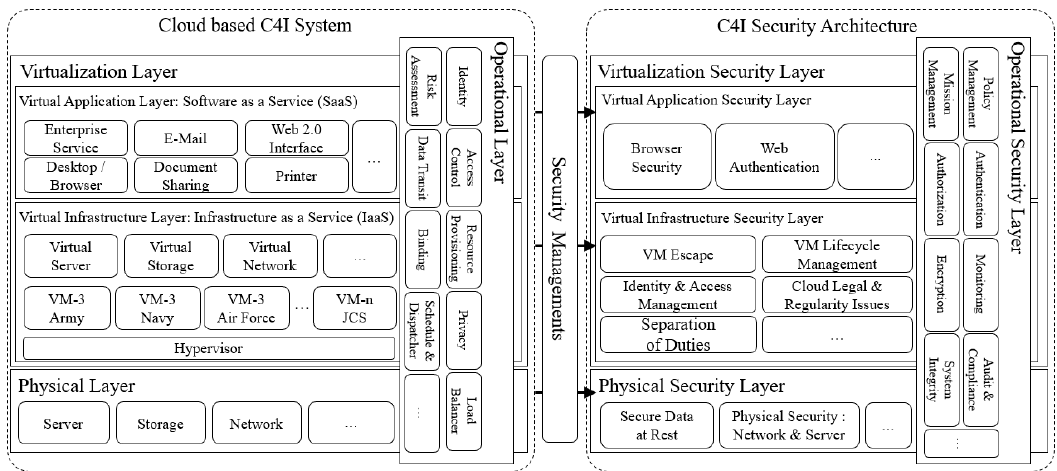
Figure 3. Proposed Security Architecture for Cloud-based C4I System.